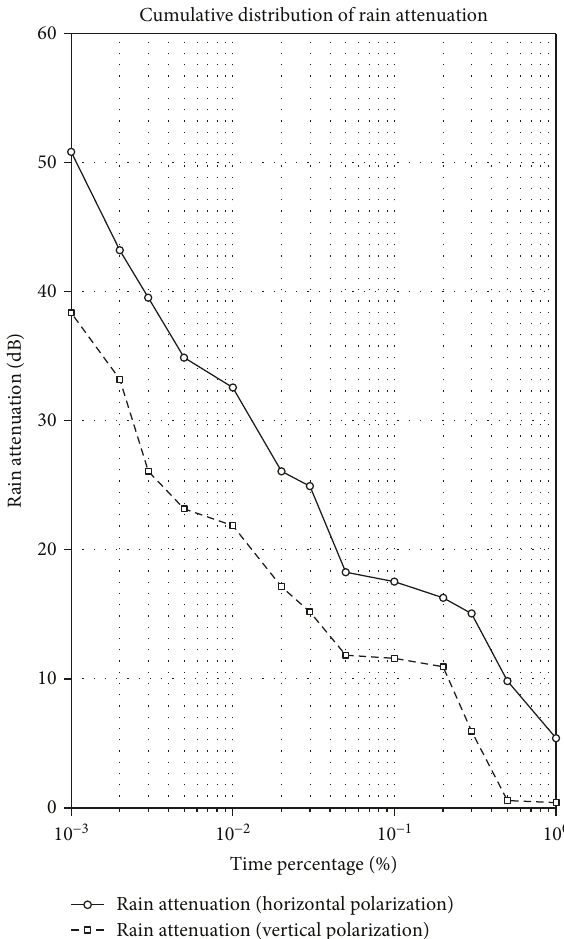
Figure 2: Rainfall rate distribution at Icheon [24].